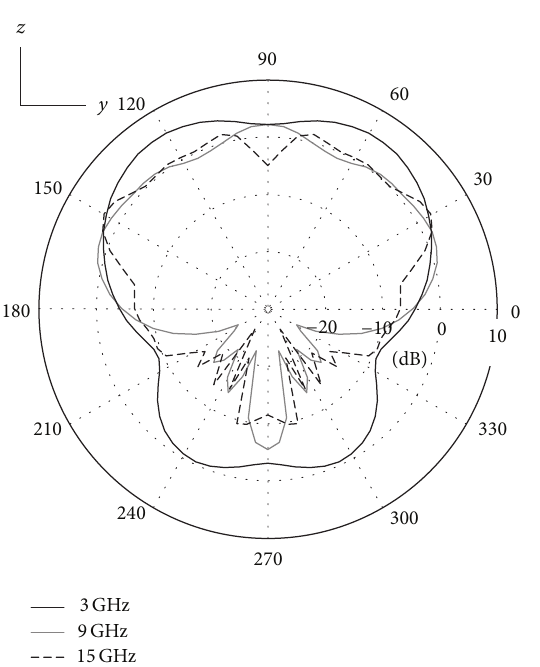
Figure 9: Radiation pattern of a conical antenna with elliptical aperture displaced of 40 mm in the yz plane.